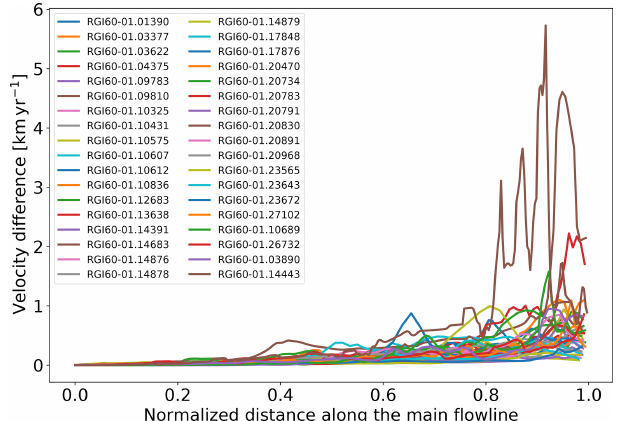
Figure 6. Glacier average velocity differences between the two out- puts of the model for a subset of marine-terminating glaciers. The differences are between the model output before accounting for frontal ablation and after accounting for frontal ablation in points along the main flow line. The x axis has been